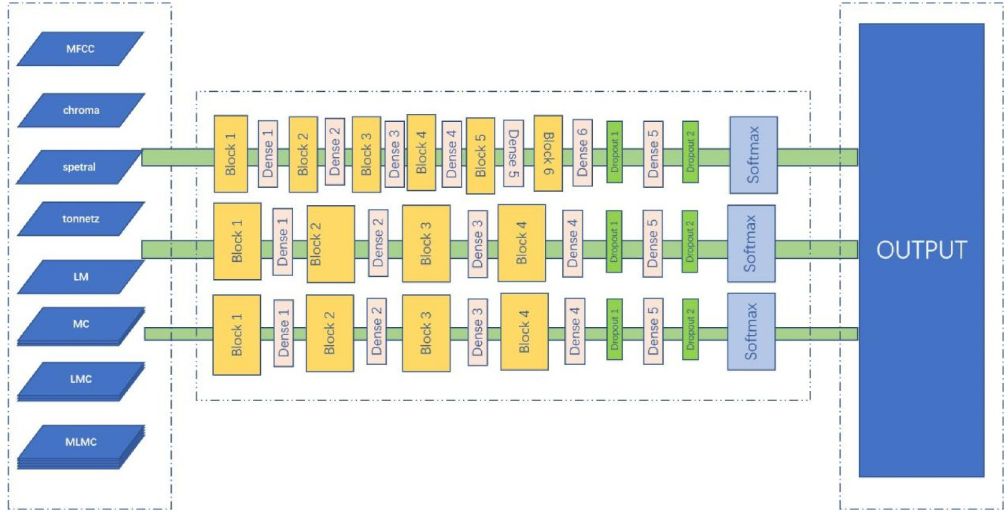
Fig 9. From top to bottom, the network structure of RNN, LSTM, GRU is